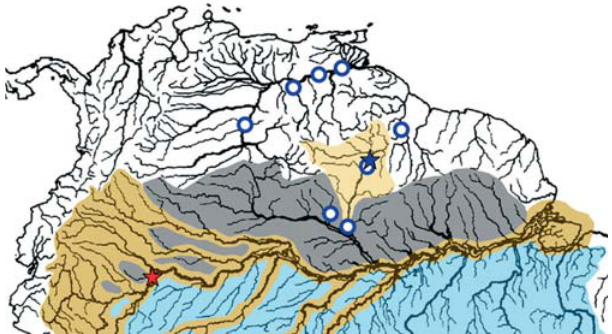
(fig. 1) (type locality: Potaro river (Essequibo dr.) at Fig. 13. Distributions of Leptodoras hasemani (open circles,